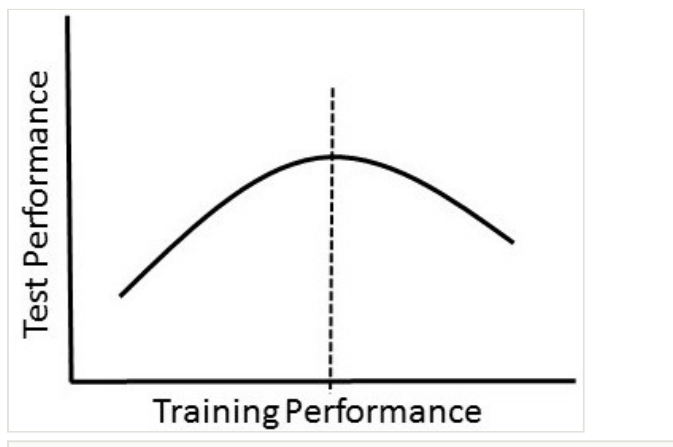
As algorithm performance on training data increases, performance on test data increases only results in over fi